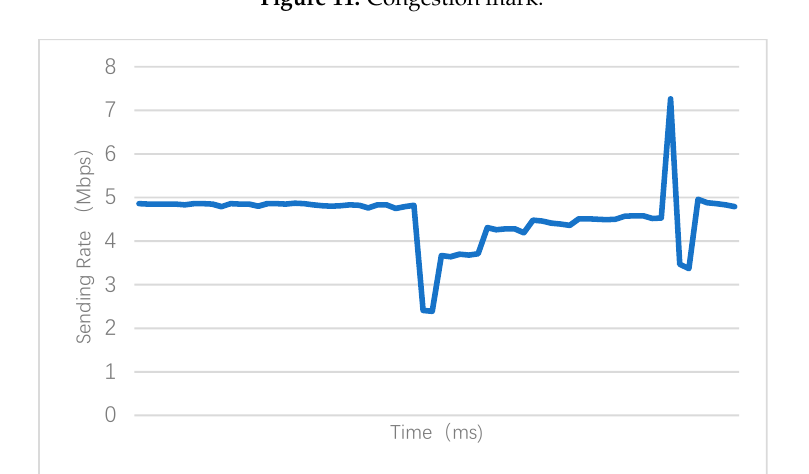
Figure 12. Sending rate of source.